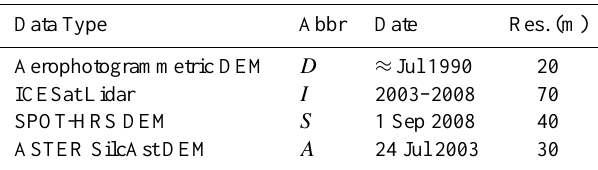
Table 4. Data sources used in Svalbard in Sect. 6), their acquisition date(s) and